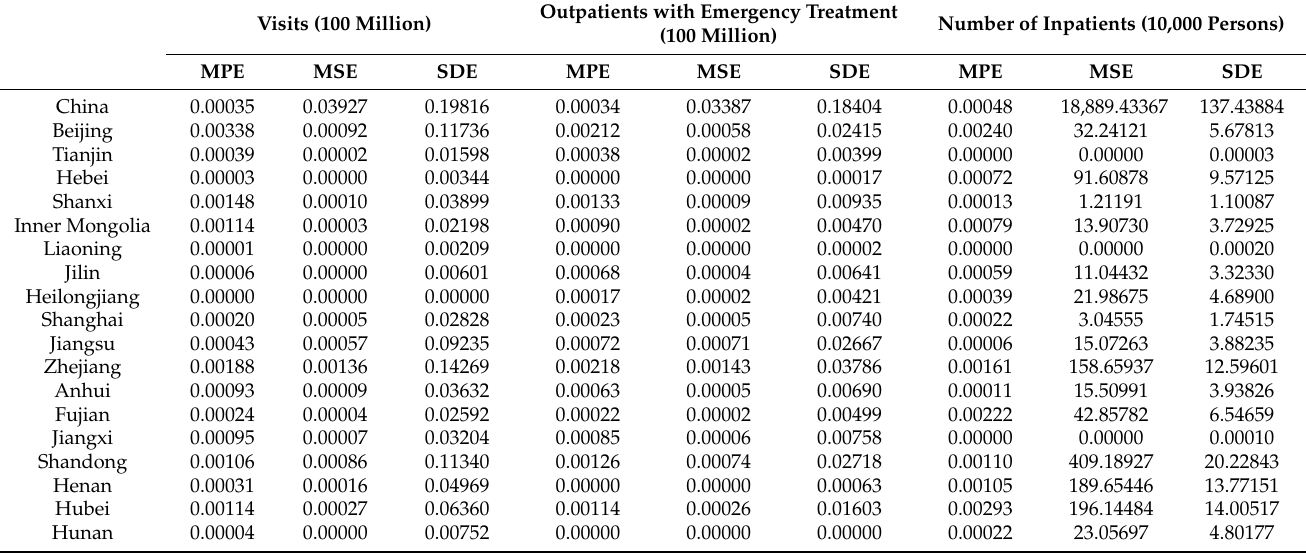
Table 3. The First Part of Forecasting performance of LS-SVM-FM